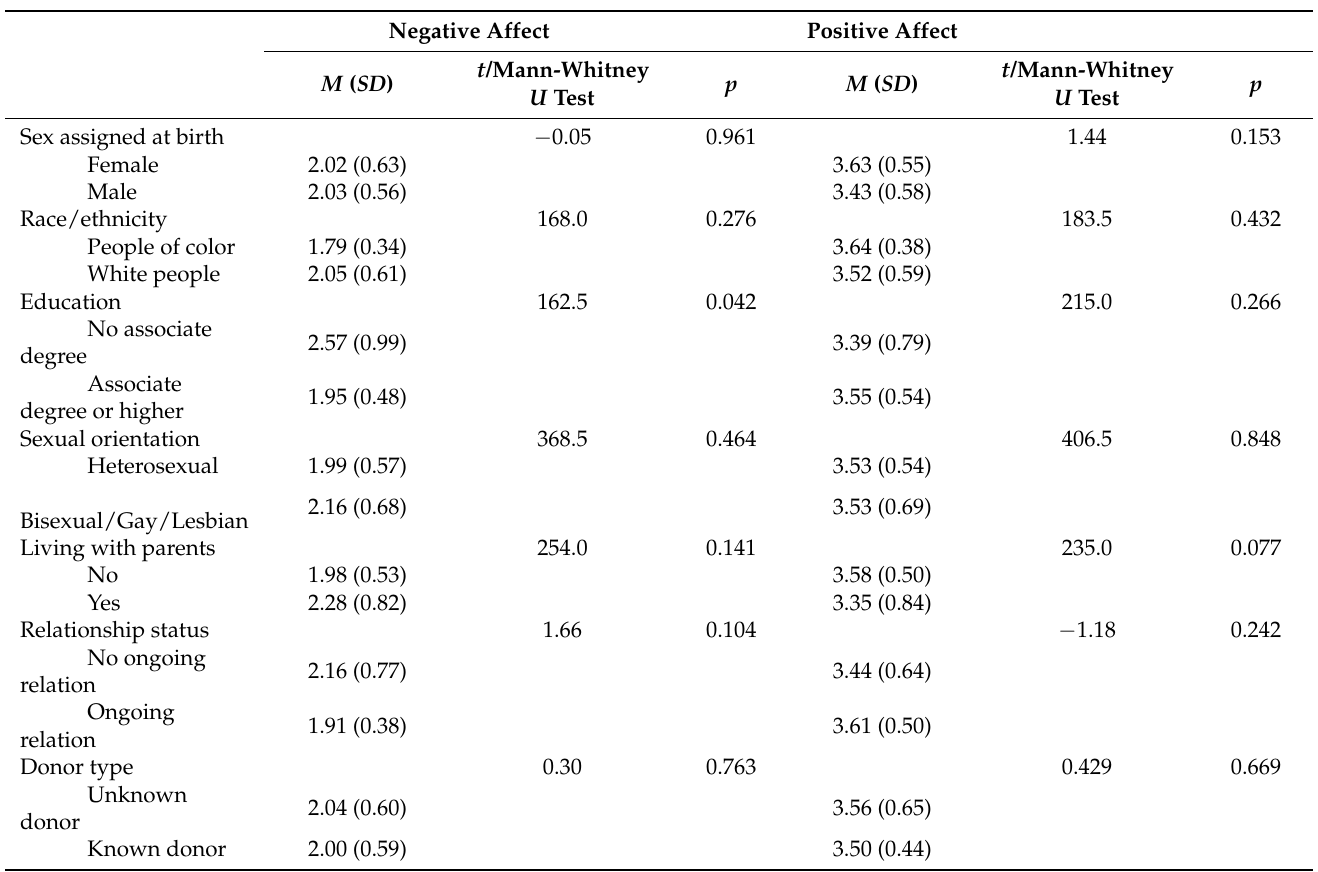
Table 1. Comparisons of sex, race/ethnicity, education, sexual orientation, living with parents, relationship status, and donor type with negative and positive affect (measured at Wave 6) (N = 71). Negative Affect Positive